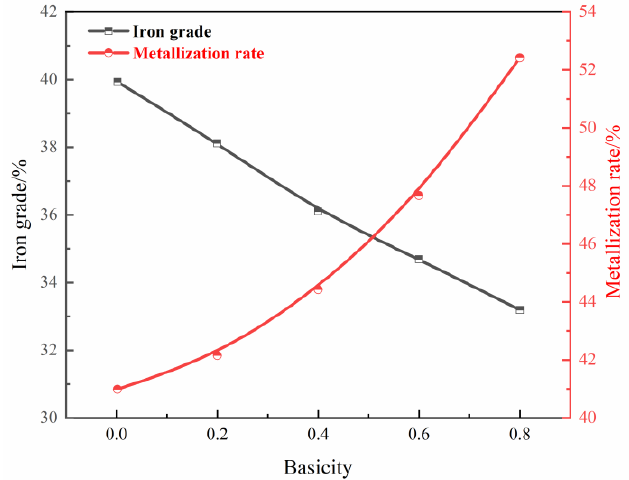
Figure 5. E ff ect of reduction duration on the pre-reduction indices. (Reduction at 1000 ◦ C, with a C / Fe Figure 5. Effect of reduction duration on the pre-reduction indices. (Reduction at 1000 °C, with a C/Fe mass ratio of 1.50, natural basicity of 0.0020). mass ratio of 1.50, natural basicity of 0.0020).